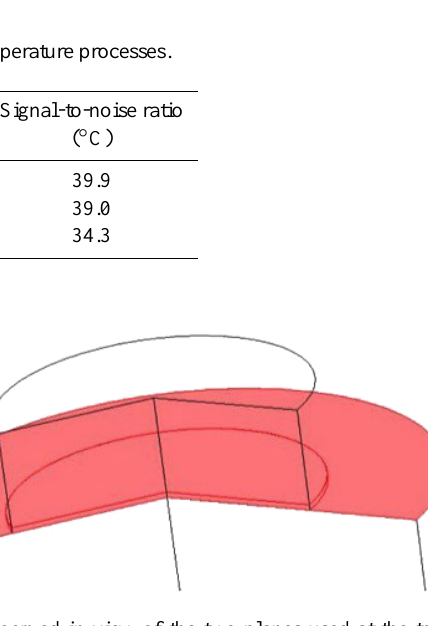
Figure 9. A zoomed-in view of the two planes used at the top of the rod. One plane was at the top of the Invar 42 rod, and the other was at the bottom of the piezoelectric